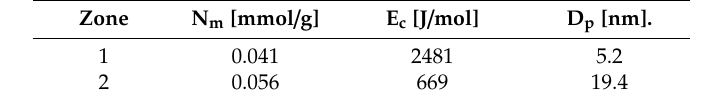
Figure 5. ( A ) Nitrogen adsorption isotherm in boehmite at − 196 °C; ( B ) Nitrogen adsorption isotherm in boehmite as a function of time at − 196 °C. Table 1. Parameter settings of two terms Dubinin equation obtained from nitrogen adsorption isotherm. Zone N m [mmol / g] E c [J / mol] D p [nm]. 1 0.041 2481 5.2 2 0.056 669 19.4